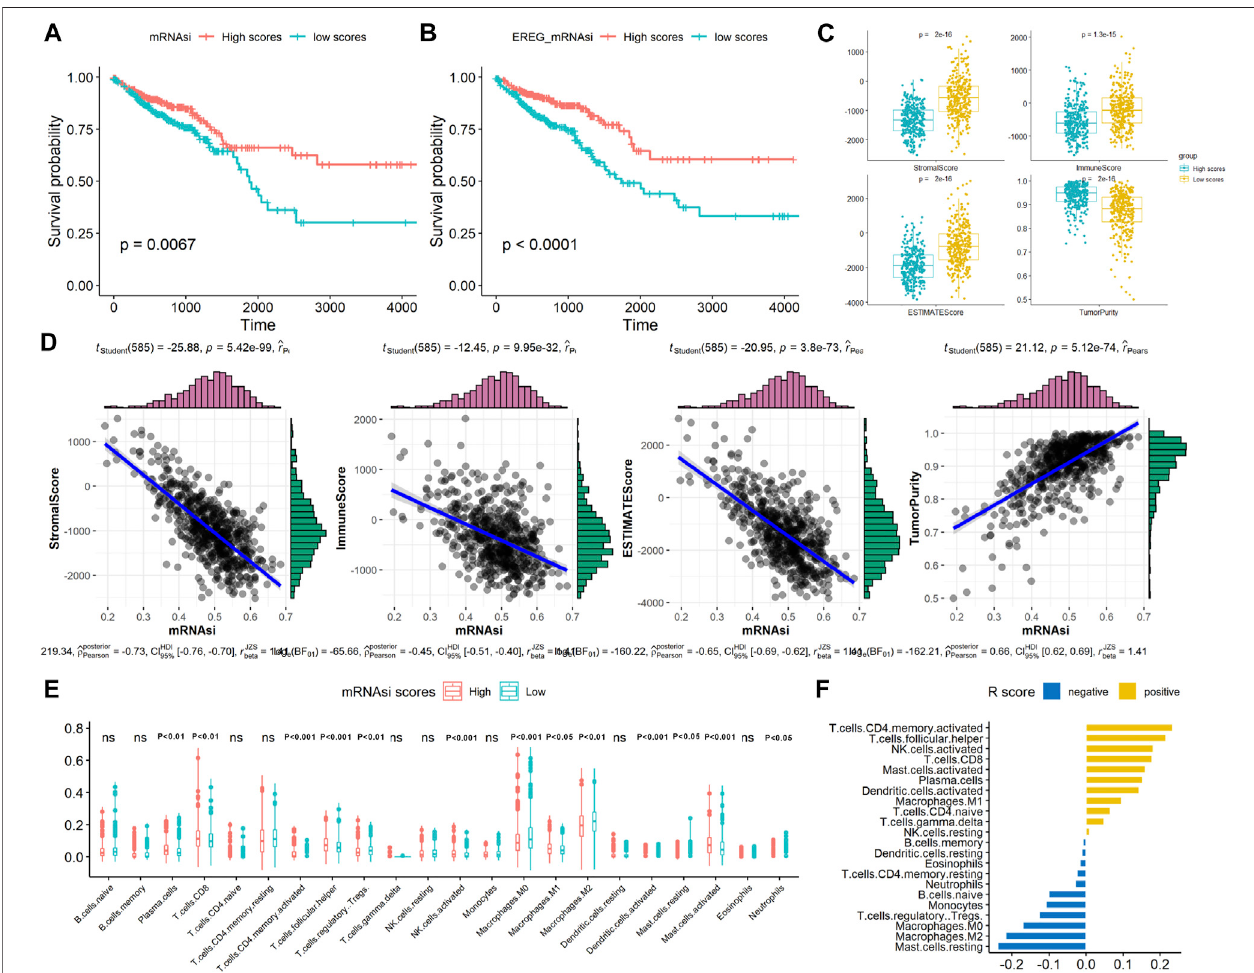
FIGURE1 | Associationsbetween thestemnessscoresand survivaland TMEpatternsin CRC. Kaplan – Meier analysesindicatedsigni fi cantlybetter OSin thehigh (A) mRNAsi scores and (B) EREG mRNAsi scores; (C) Comparison of immune, stromal, ESTIMATE scores, and tumor purity between high and mRNAsi scores; (D) Correlation of mRNAsiscores with immune, stromal, ESTIMATE scores, and tumor purity; (E) Comparison of TIICs between high and mRNAsi scores; (F) Correlation of mRNAsi scores with TIICs (R value).